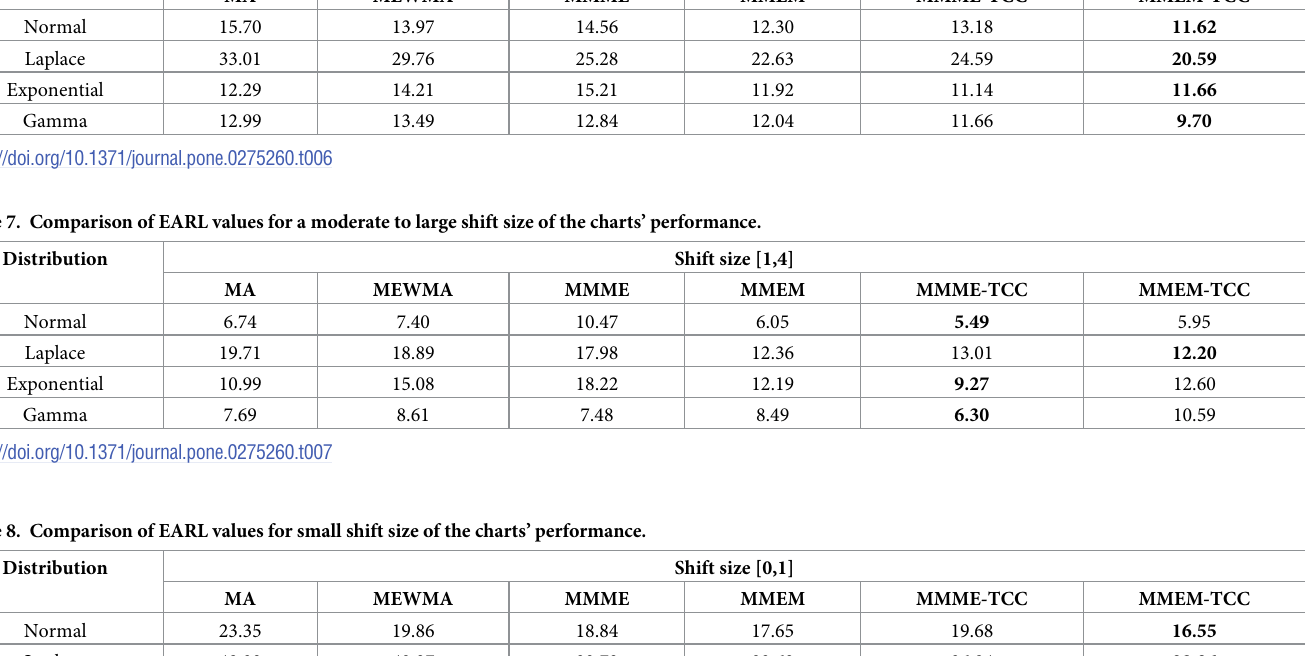
Table 6. Comparison of EARL values for the overall shift size of the charts’ performance. Distribution Normal Laplace